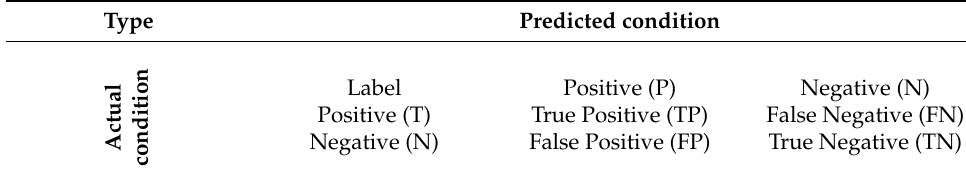
Table 4. Confusion matrix.